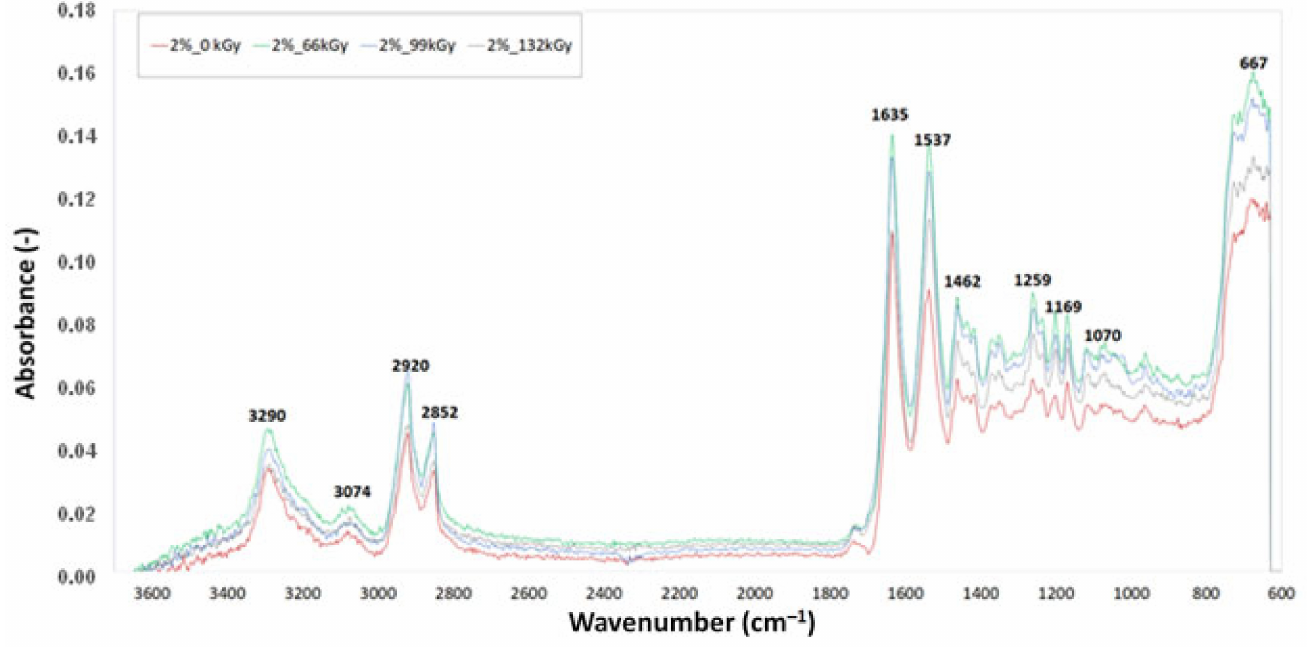
Figure 11. Fourier-transform infrared spectroscopy of sample